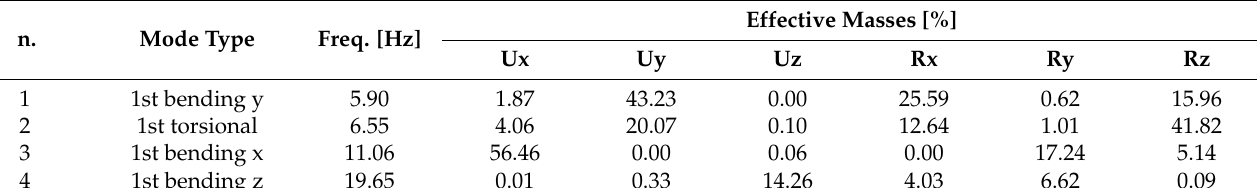
Table 3. Eigenfrequencies and effective masses (first four modes).